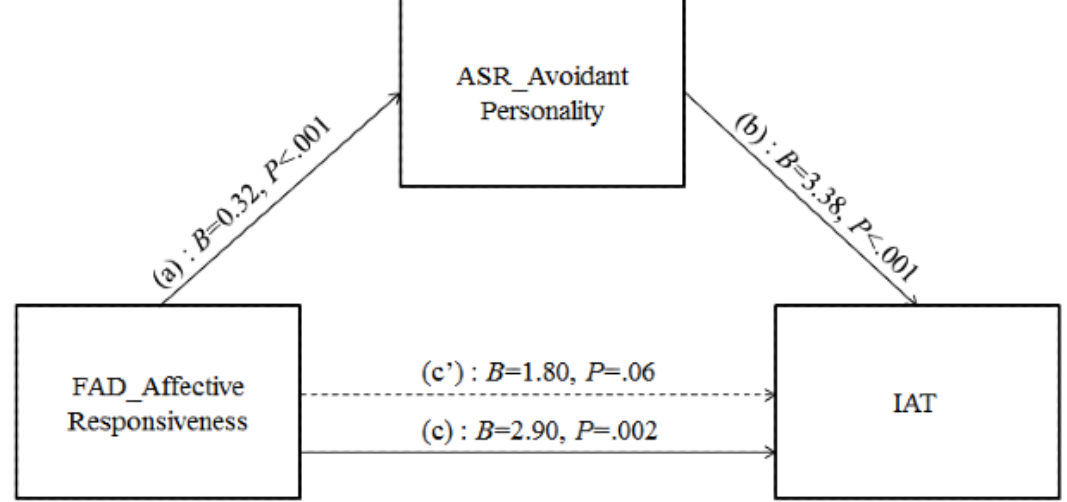
Figure 3. Simple mediation model for avoidant personality problems mediating the association between affective responsiveness and internet addiction. (a) Direct effect of affective responsiveness on avoidant personality traits; (b) direct effect of avoidant personality traits on IAT score; (c’) direct effect of affective responsiveness on IAT score; (c) total effect (a*b+c’) of affective responsiveness on IAT score. ASR: Adult Self-Report; FAD: Family Assessment Device; IAT: internet addiction